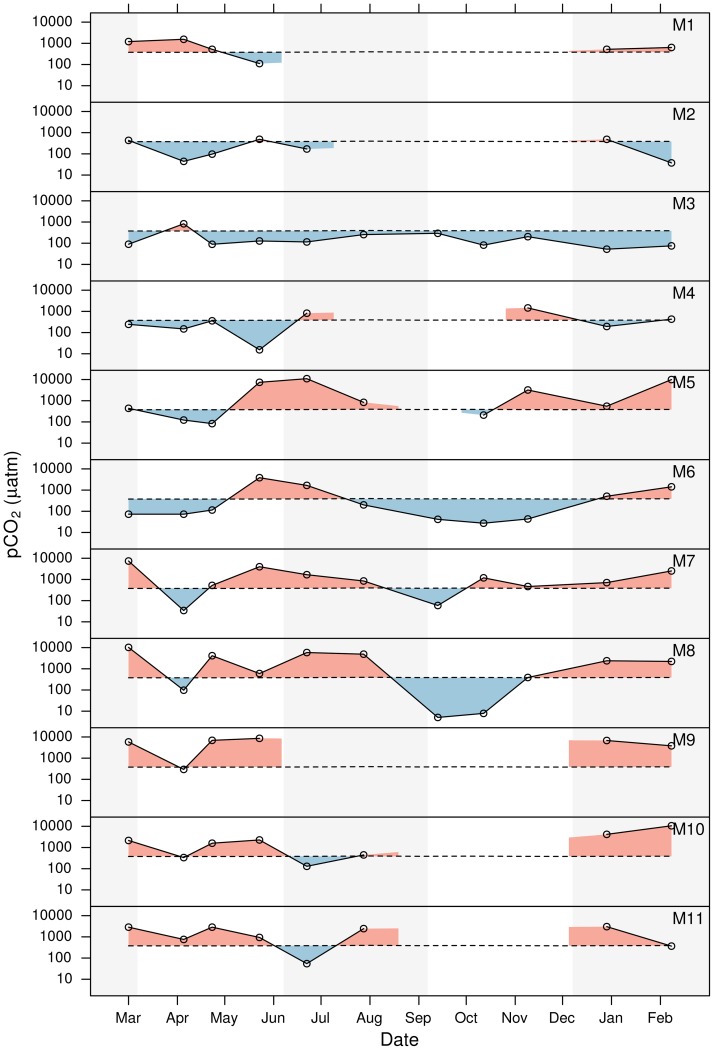
Seasonal variation in  at each of the sites.The solid dark grey line is the measured . Gaps in the data represent periods when water levels were too low (<0.1 m) for sampling. Light and dark shading represents seasons.